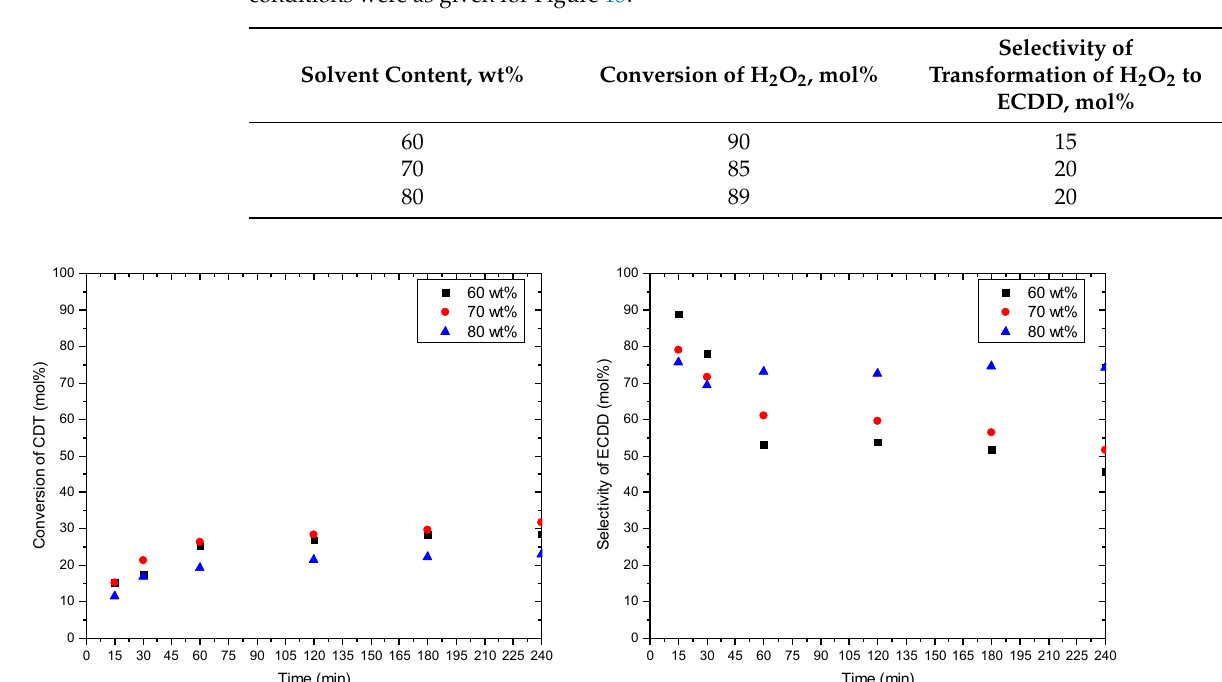
Table 3. Values of the conversion of H 2 O 2 and selectivity of transformation of H 2 O 2 to ECDD obtained after 4 h of performing the reaction with different i-PrOH solvent compositions. Reaction conditions were as given for Figure 13.